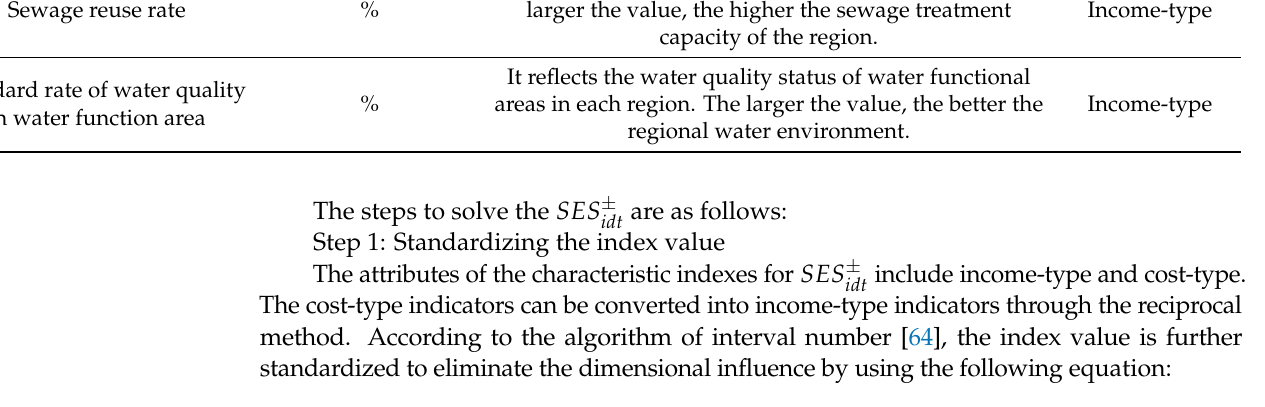
emission per unit of GDP.